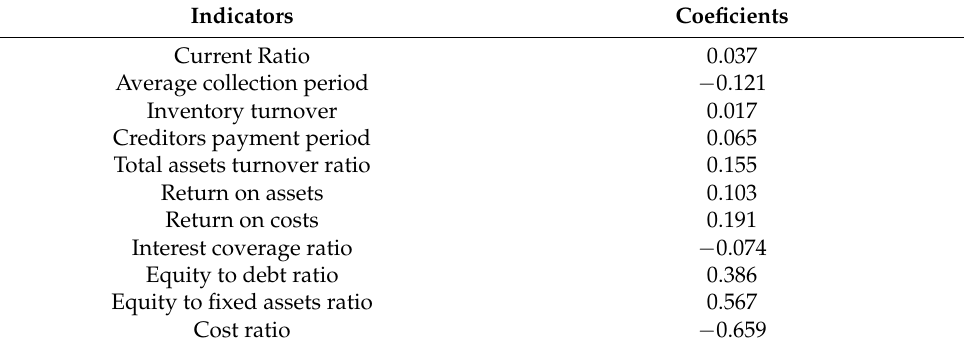
Table 6. Standardized canonical discriminant function coefficients.